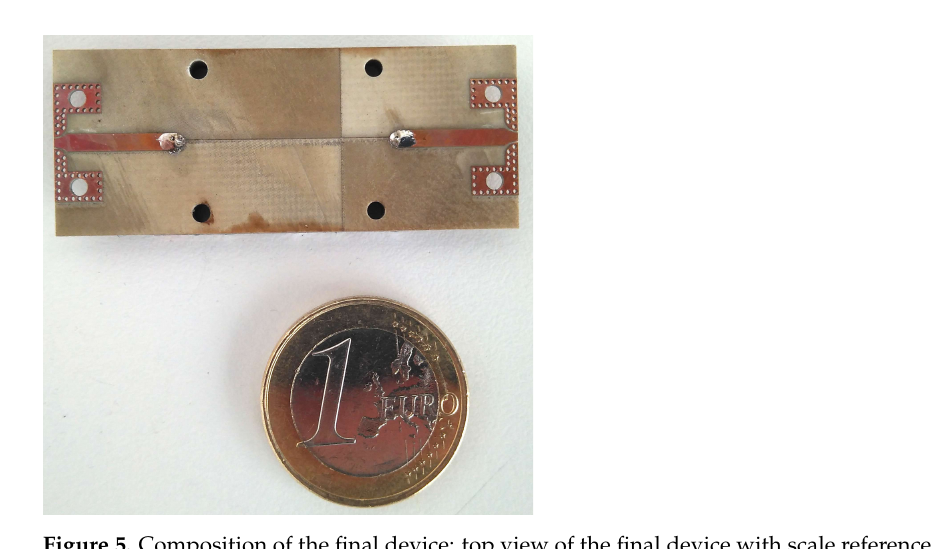
Figure 5. Composition of the final device: top view of the final device with scale reference. The device was measured with an Anritsu vector network analyzer and a de-embed on the initial microstrip was made using the custom TRL calibration kit shown in Figure 6. As it is revealed in Figure 7 there is good agreement between simulation and measurements: return loss is above 15 dB in the whole band of interest (as can be seen in Figure 7 left), whereas insertion loss is below 1 dB for f < 14.5 GHz, below 1.5 dB for 14.5 < f < 17 GHz and below 2.5 dB for 17 < f < 20 GHz (see Figure 7 right).